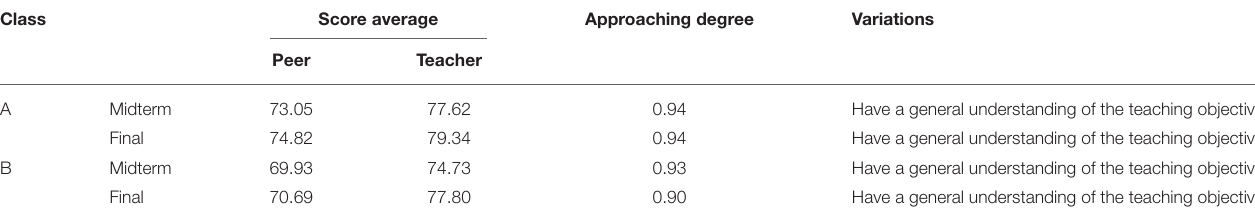
TABLE 6 | Teacher and student score approaching degree.